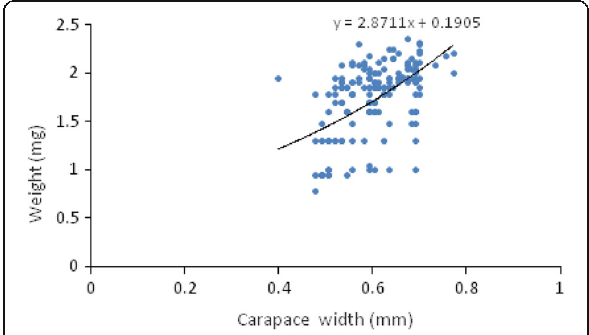
Fig. 2 The width-observed weight relationship of H. marsupialis females